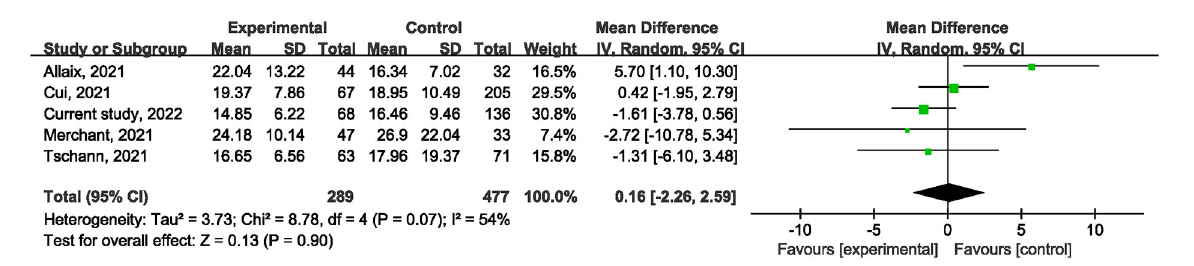
FIGURE7 The impact of the COVID-19 pandemic on mean lymph node yield.